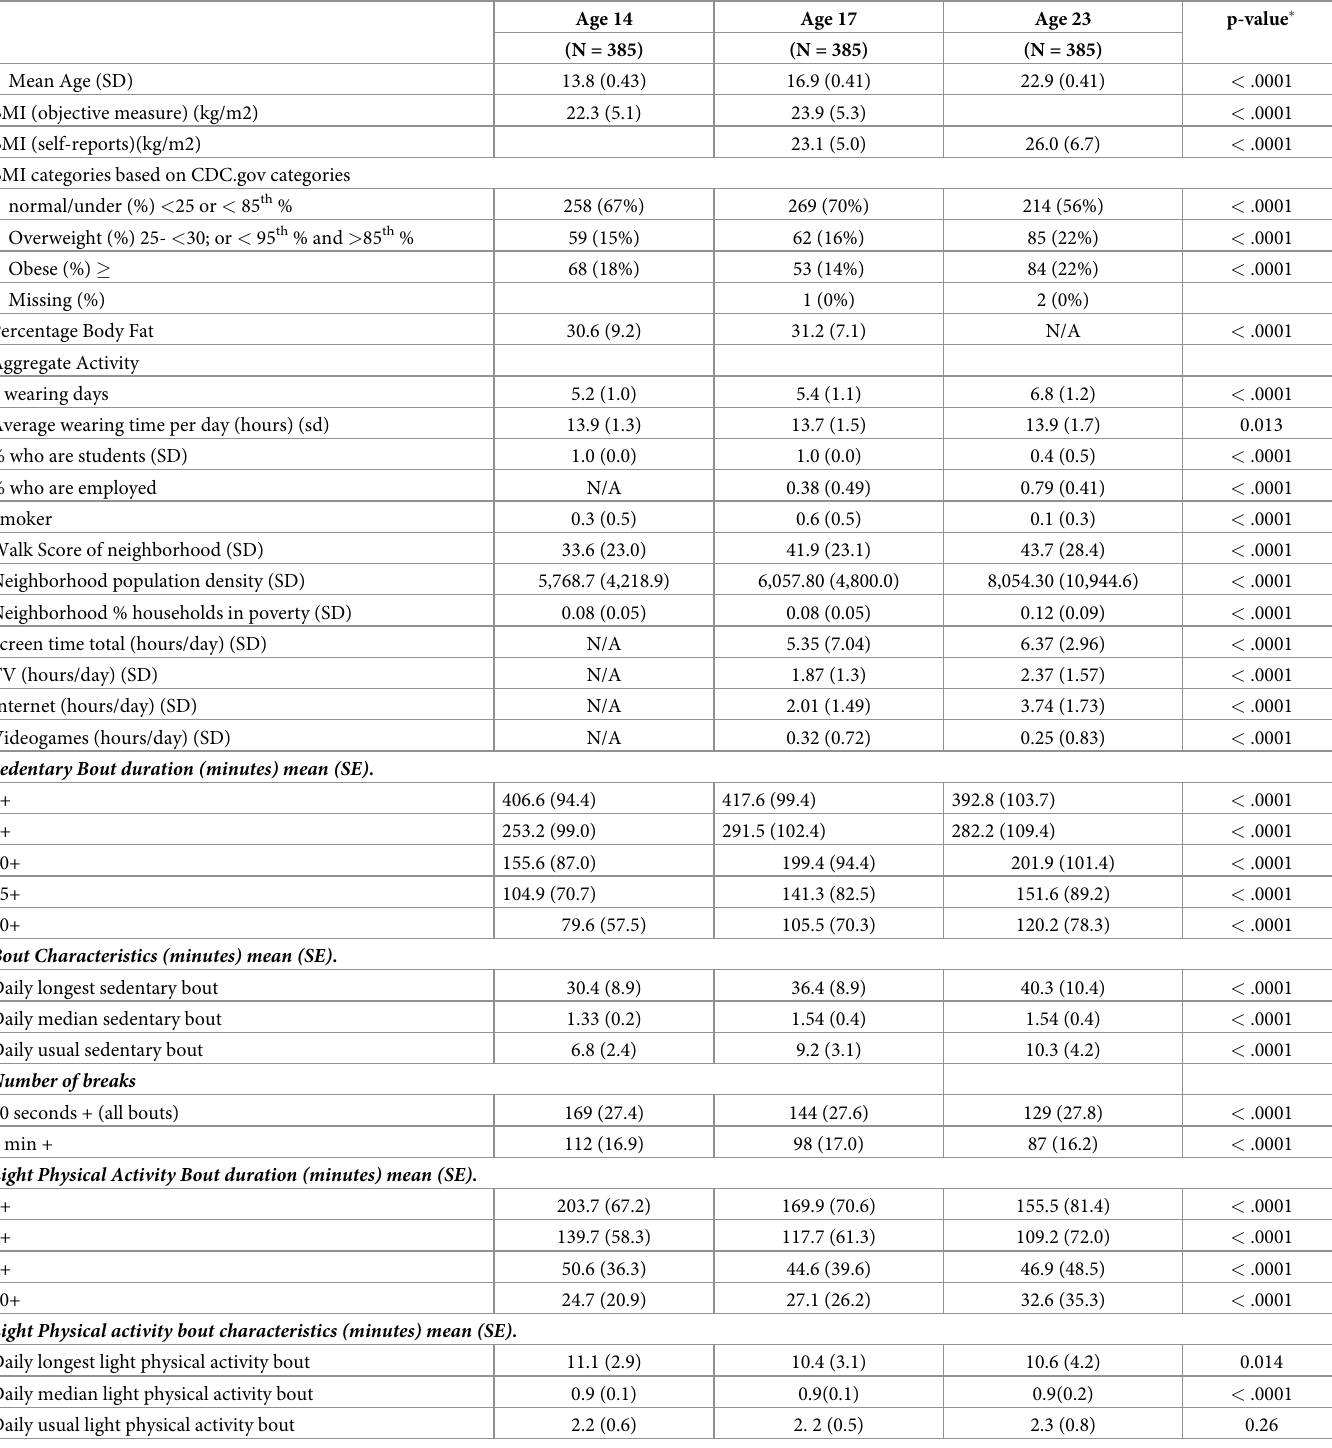
Table 1. Population characteristics and LPA and SED behaviors by